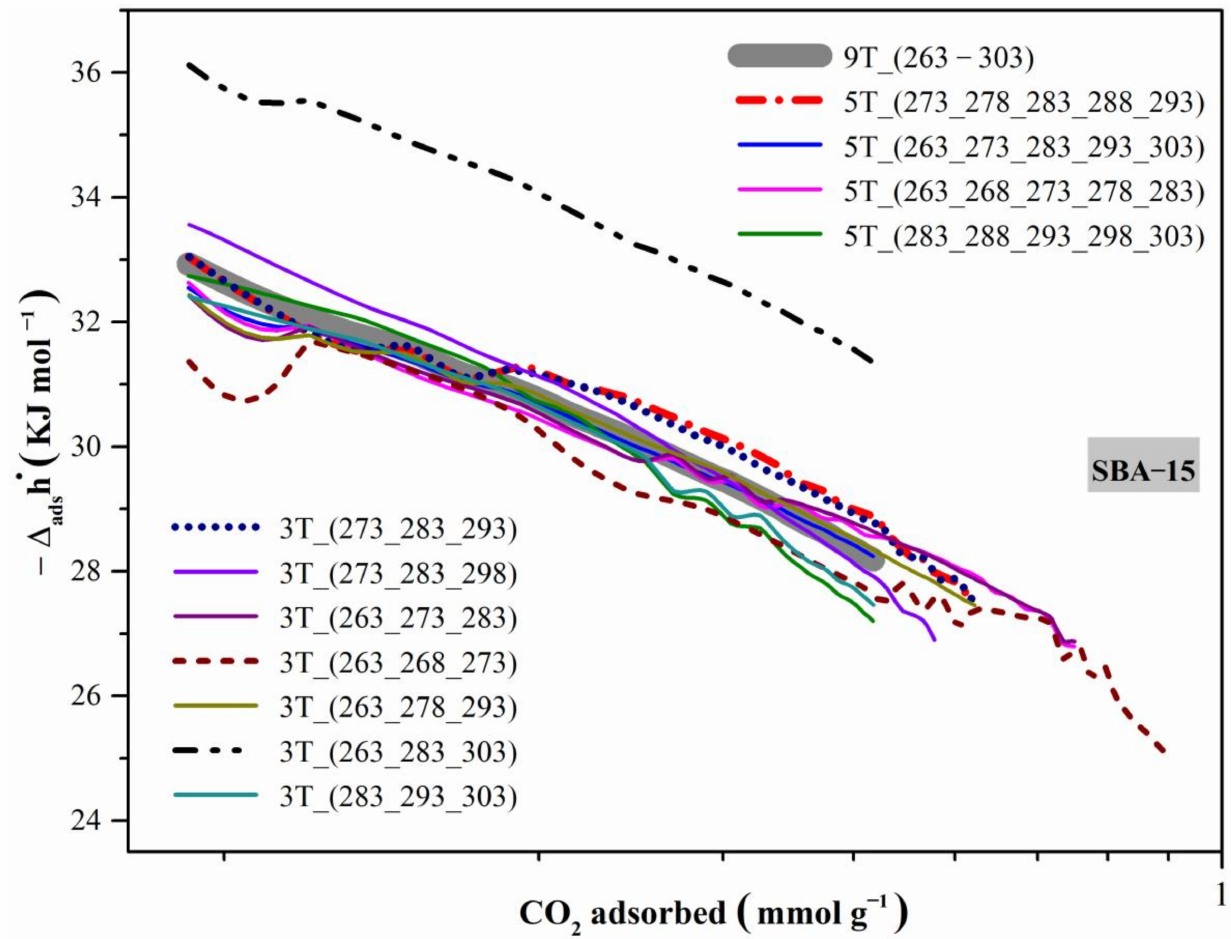
Figure 10. CO 2 isosteric enthalpy of SBA-15 calcinated at 623